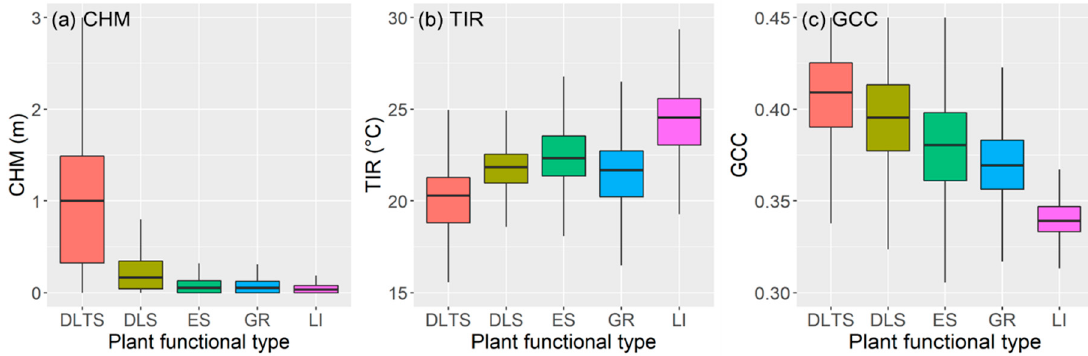
Figure 6. Boxplots of the canopy height model ( a ), thermal infrared ( b ), and green chromatic coordinate ( c ) of different plant functional types (PFTs) from the case study. DLTS: deciduous low to tall shrub; DLS: deciduous low shrub; ES: evergreen shrub; GR: graminoid; LI: lichen.